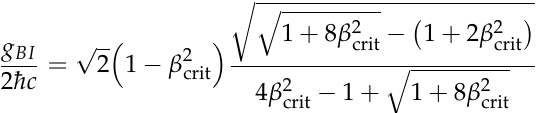
(cid:0) g BI (cid:1) 2 , and 2¯ hc